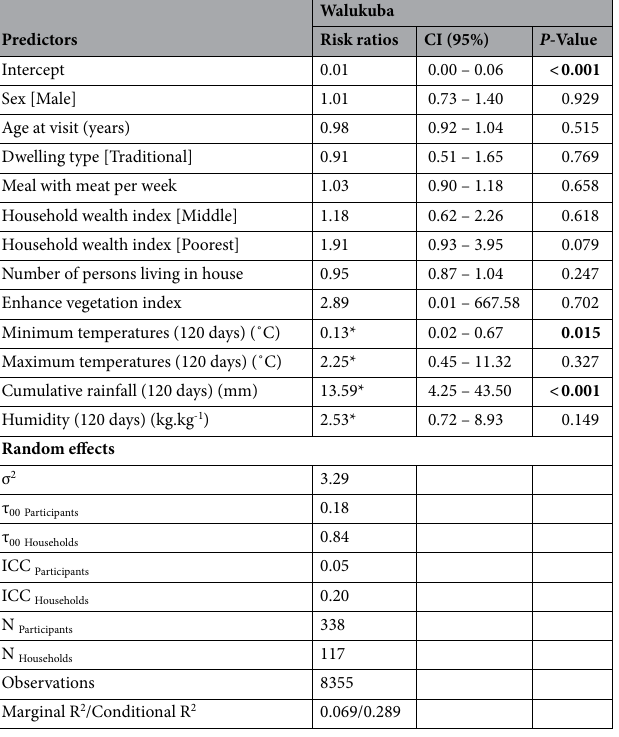
Table 3. Summary of GLMM model for Walukuba. Significant values are in bold. *Risk ratio of malaria when the meteorological linear variable changes from its minimum to its maximum value.